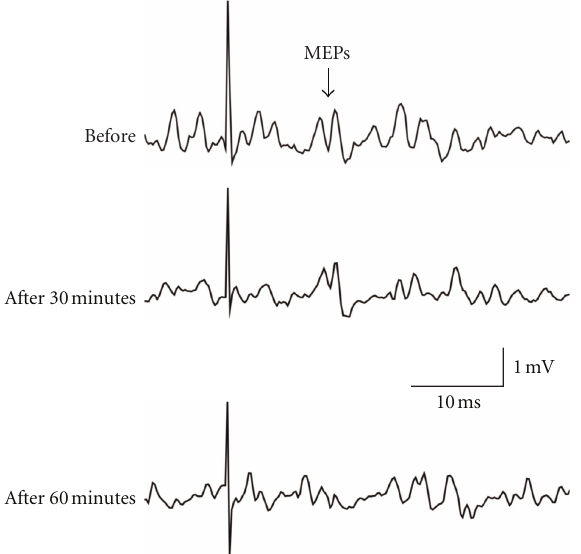
Figure 5: A sample of changes in MEPs of FDI during foramen magnum stimulation with MVC under the test 2